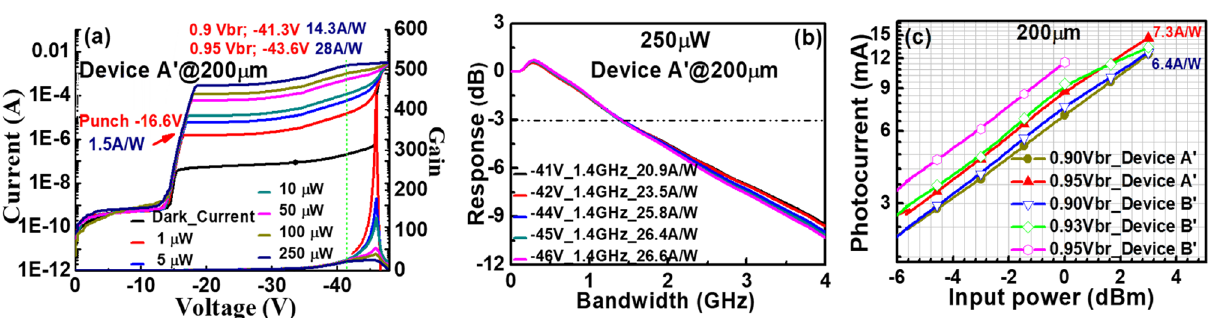
Figure 9. Device A ′ with a 200 µm active window diameter showing. ( a ) Measured dark current, photocurrent, and operation gain versus bias voltages under different optical pumping powers. ( b ) Bias dependent O-E frequency responses under 250 µW optical pumping power. ( c ) DC output photocurrent vs. input optical power at different bias voltages of devices A ′ and B ′ with the same active window diameter of 200